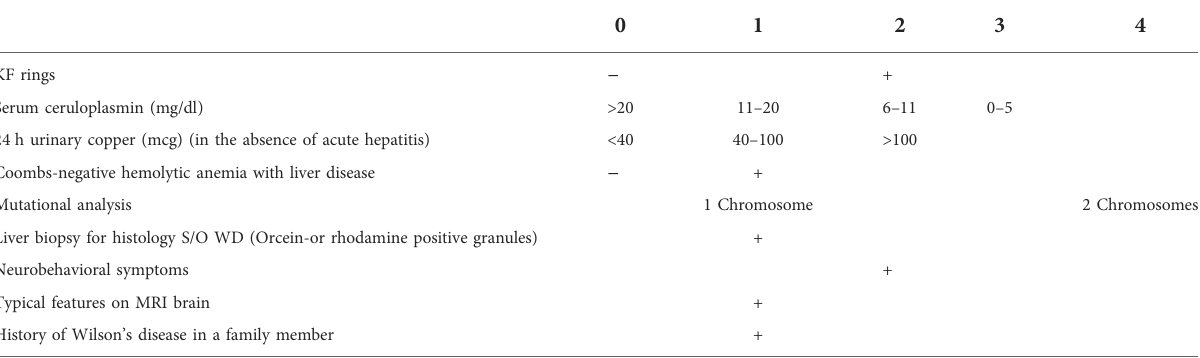
TABLE 1 Leipzig scoring system for diagnosis of Wilson ’ s